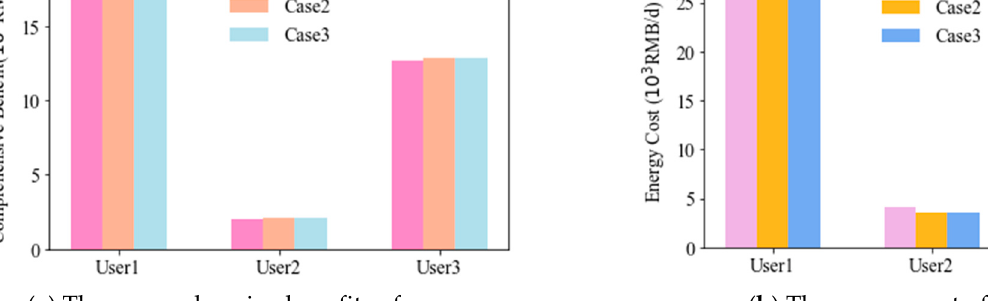
Figure 6. The benefits of operator in summer. The pricing strategies of operator in case1 in summer are shown in Figure 7. Users do not participate in energy pricing, and the operator directly optimizes energy prices based on the total load power. Users can only passively accept energy prices. Because of the limited space, this article will not list all the strategies of participants but only give some examples of results. The operator sets different energy prices for dif- ferent users in order to guide users to use energy rationally. For example, as shown in Figure 8a, in case2, the operator sets a higher heating price for user3 when user3 consumes more heating energy to guide user3 to reduce the heating load during peak time. As shown in Figure 8b, the operator sets a higher cooling price for user2 when user2 con- sumes more cooling energy to guide user2 to reduce the cooling load during peak time. As shown in Figure 8c, operator set higher electricity prices for user1 at the peak of elec- tricity consumption of user1 to guide user1 to shift part of the peak load to valley hours to reduce the peak-to-valley difference. Additionally, it also shows that, in the interactive game process, the operator is dominant, which is in line with the characteristics of the master–slave game.